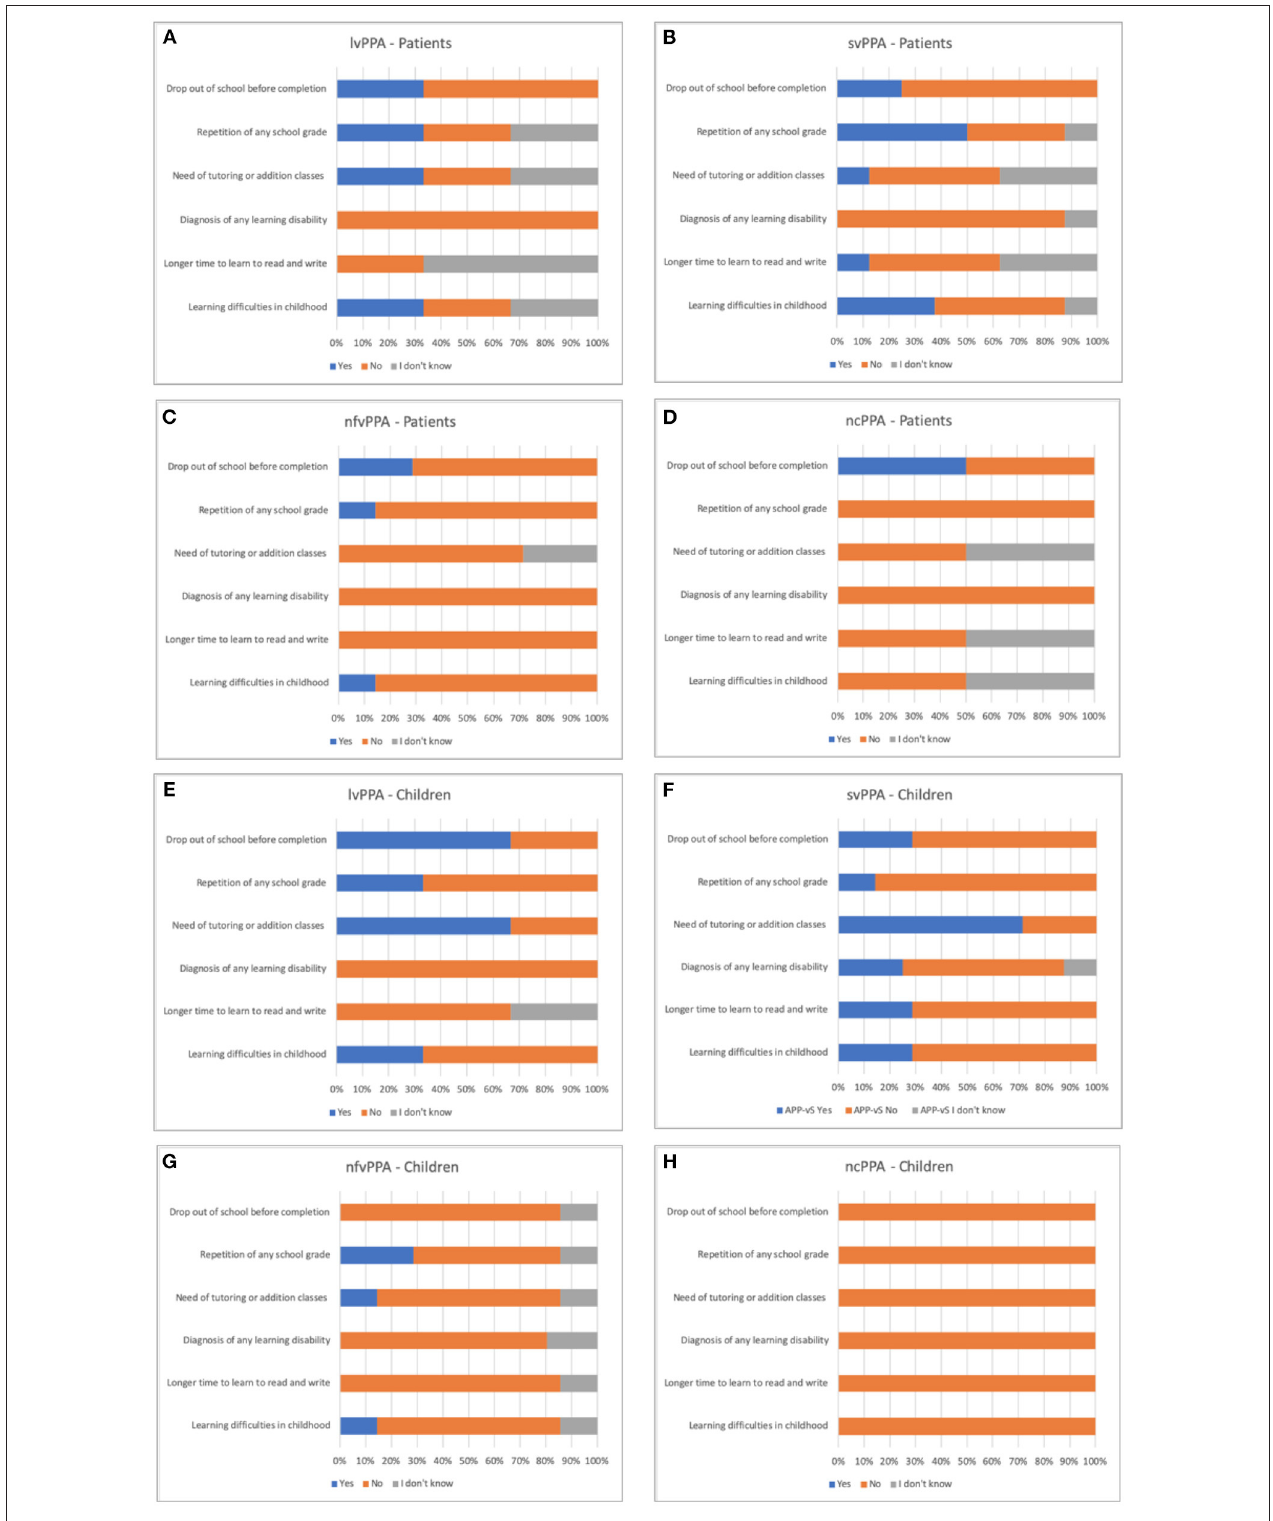
FIGURE 2 | Description of the percentage of responses in the questionnaire of learning difficulties history of the PPA variants. AD, Alzheimer’s disease; PPA, primary progressive aphasia; lvPPA, logopenic variant primary progressive aphasia; svPPA, semantic variant primary progressive aphasia; nfvPPA, nonfluent/agrammatic variant primary progressive aphasia; ncPPA, non-classifiable primary progressive aphasia. (A) responses of lvPPA patients; (B) responses of svPPA patients; (C) responses of nfvPPA patients; (D) responses of ncPPA patients; (E) responses of lvPPA children; (F) responses of svPPA children; (G) responses of nfvPPA children; (H) responses of ncPPA